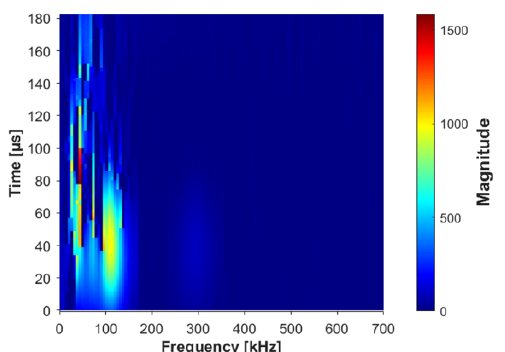
Figure 12. Minimal lateral dimension plotted against position of central frequency peak.